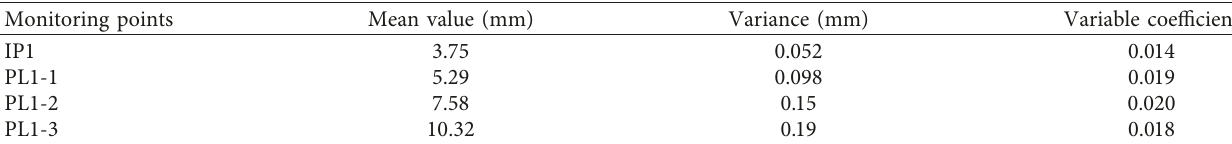
Figure 7: 2D map of the Gaussian random fields: (a) θ � 30m, (b) θ � 50m, and (c) θ � Table 3: Properties of the hydraulic displacement component at the normal water level.